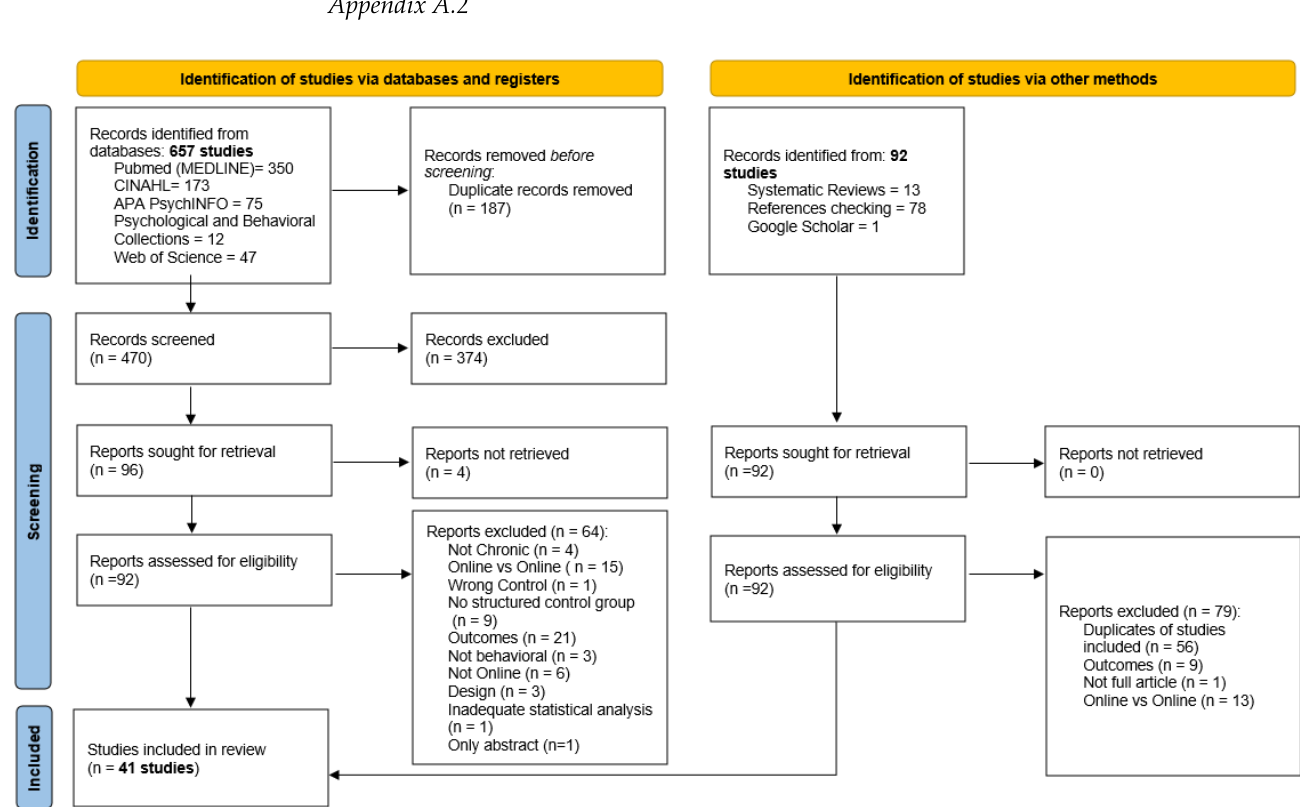
Figure A1. PRISMA Flowchart of studies selection.